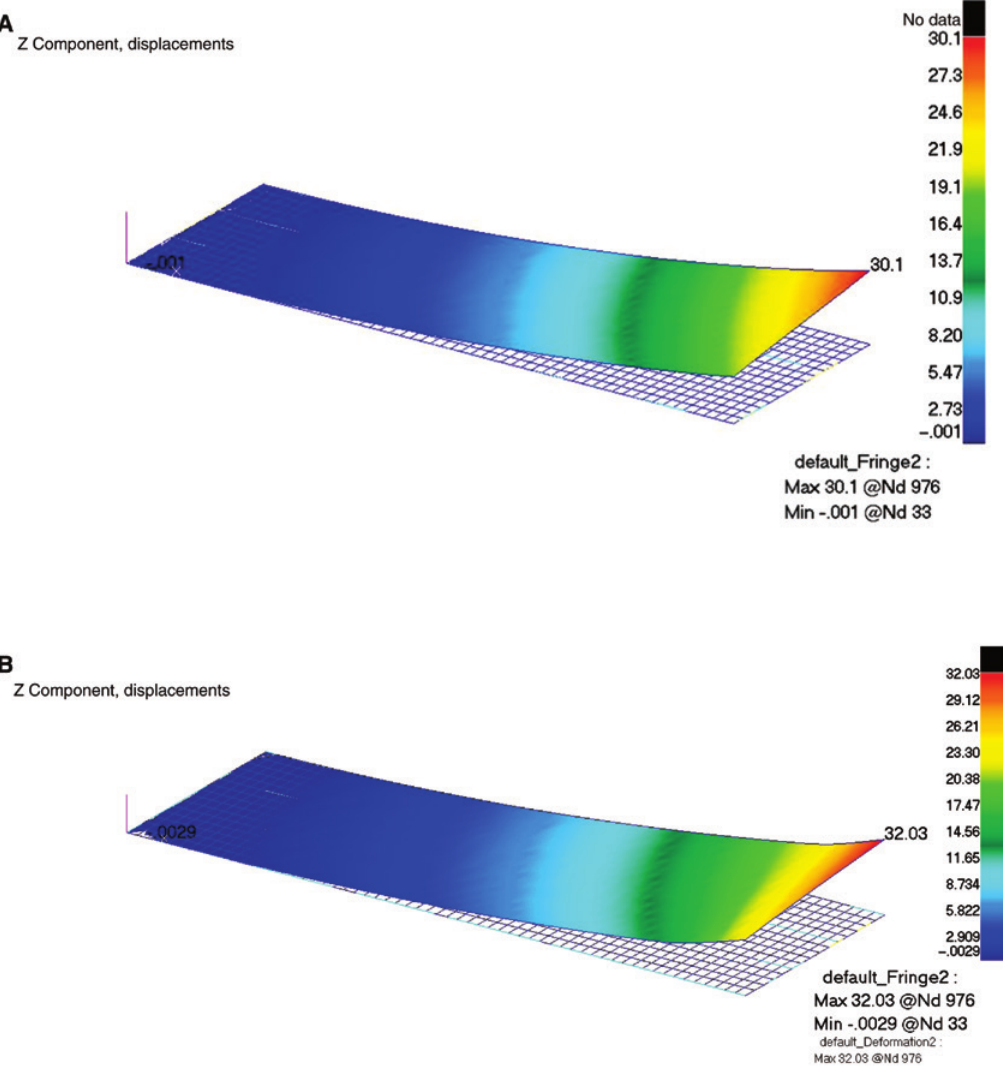
= 1 N/mm m = 10 N. z x